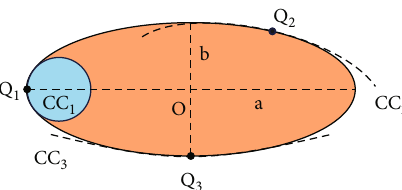
Figure 2: Schematic diagram of circular defect.